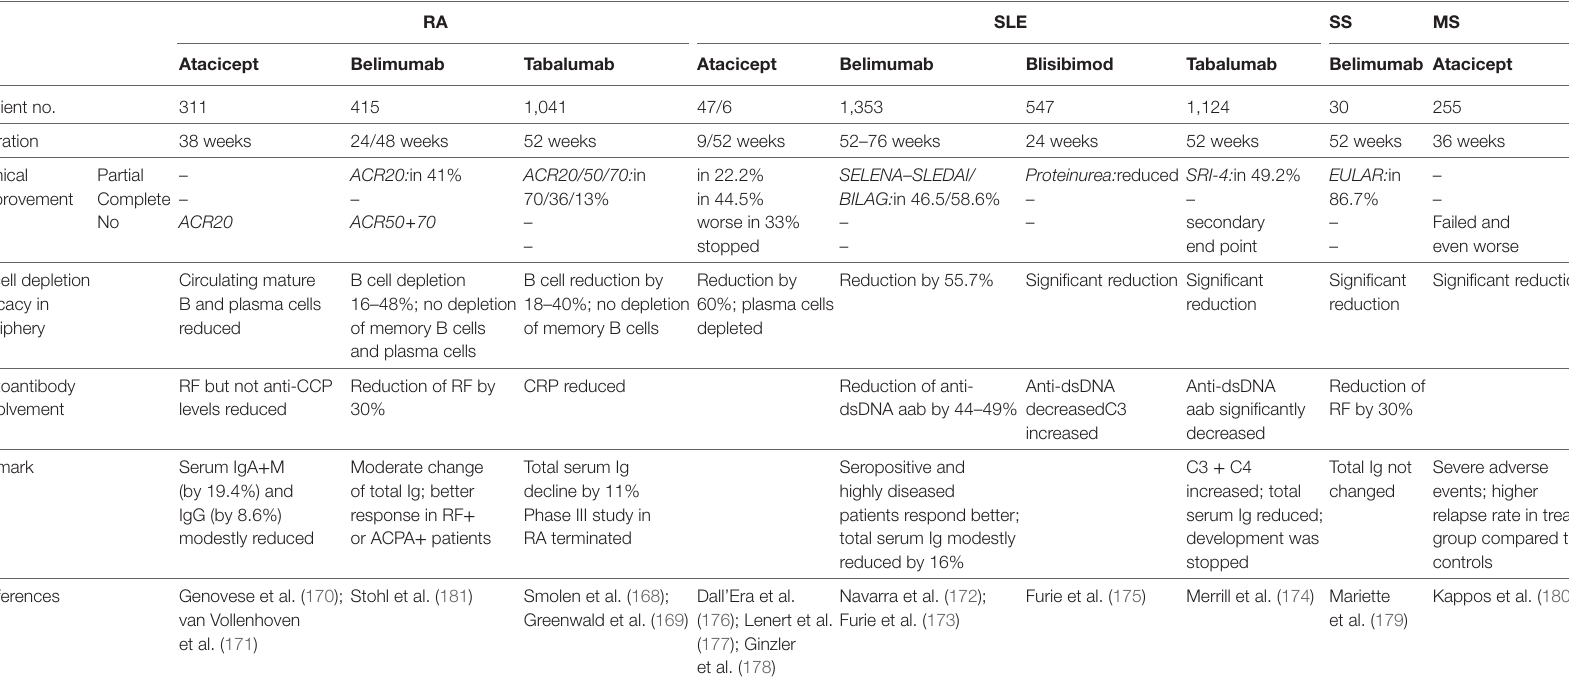
TABLe 2 | Efficacy of belimumab, tabalumab, and atacicept.